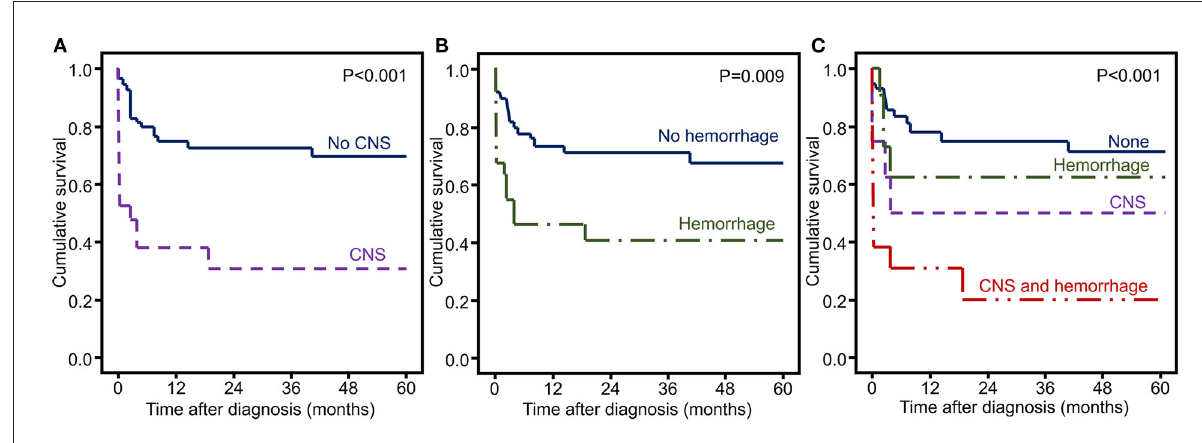
FIGURE1 Kaplan–Meier curves of HLH patients with significant risk factors of mortality. (A) CNS involvement, (B) hemorrhagic symptoms, and (C) CNS and hemorrhagic